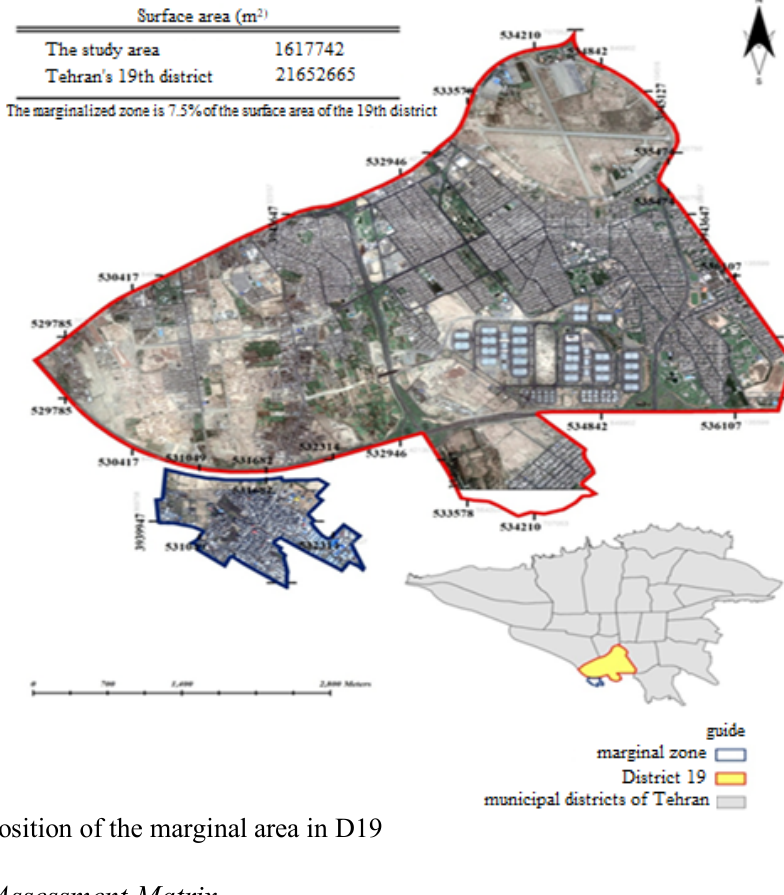
Figure 1. The position of the marginal area in